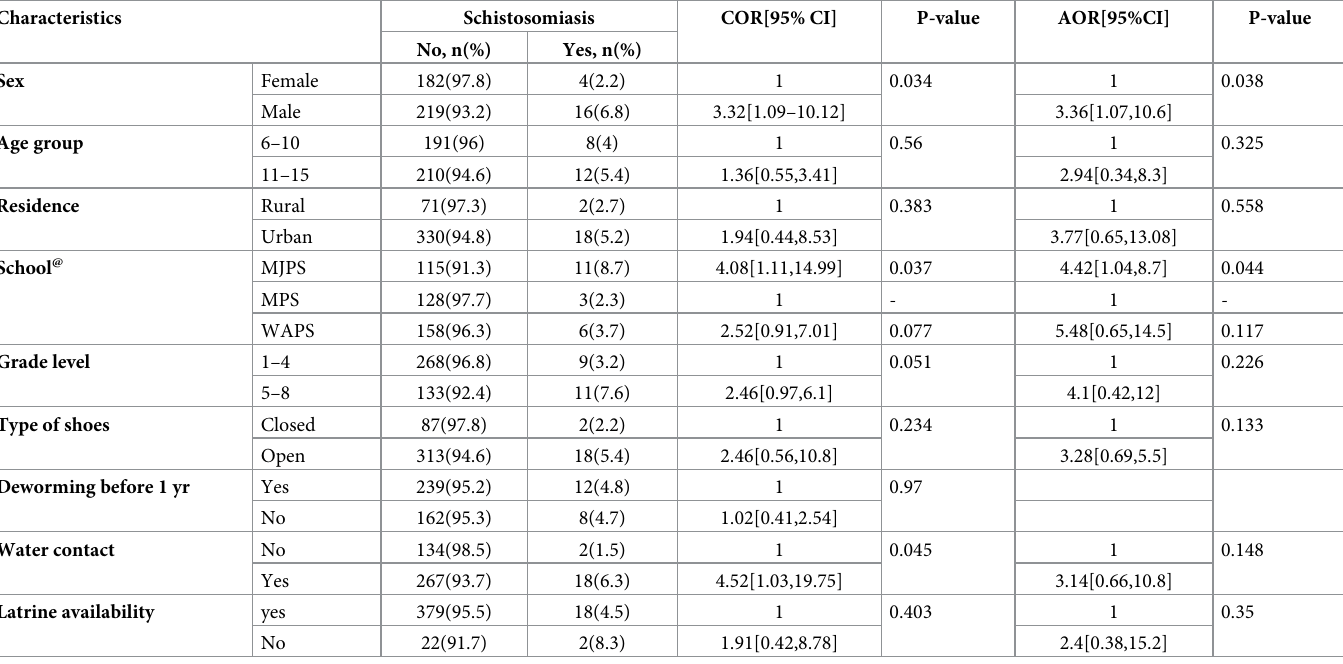
Table 4. Factors associated with occurrence of intestinal schistosomiasis among schoolchildren in northwest Ethiopia (n = 421).